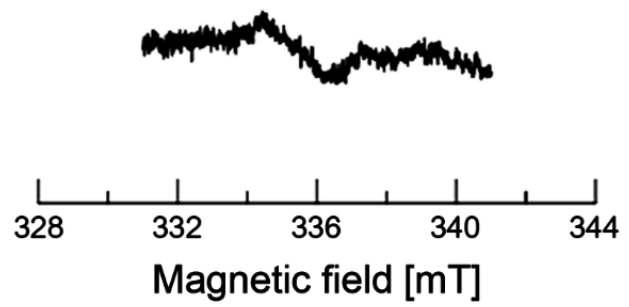
Figure 7. EPR spectra of red peel-related samples. Upper spectrum is for the dry red peel sample. The bottom one is for the solution of red peel samples submerged in distilled water. The bottom spectrum was accumulated four times.